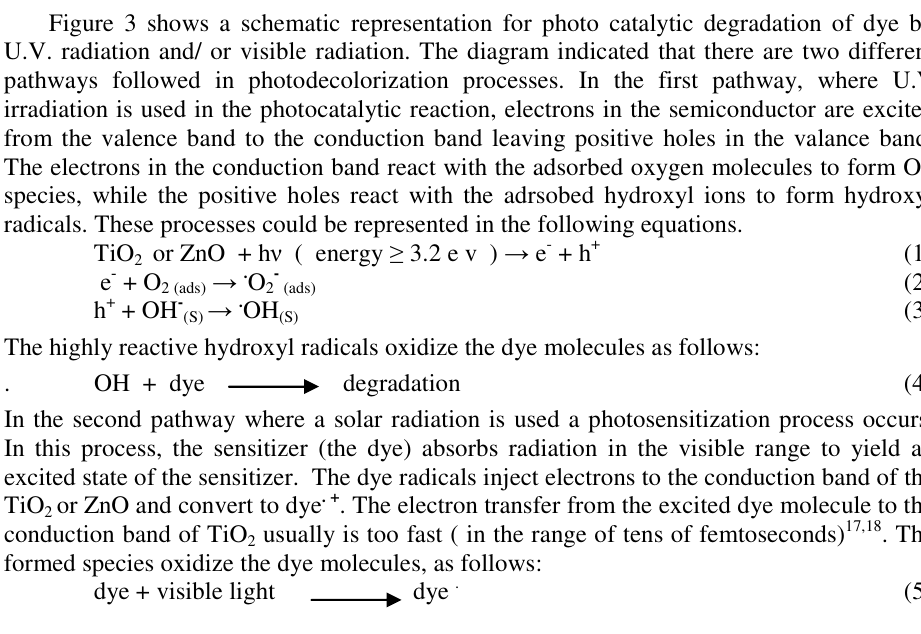
Figure 2. Photocatalytic degaradation of textile industrial wastewater on titanium oxide and zinc oxide at